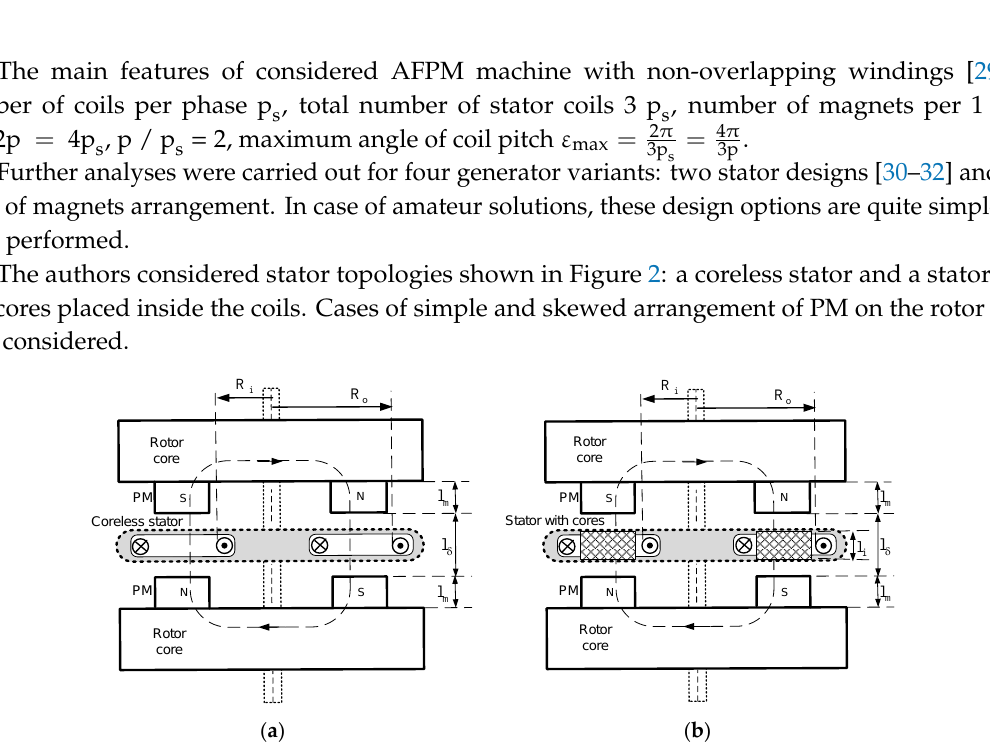
Figure 1. Axial Flux Permanent Magnet (AFPM) generator model with ANSYS Maxwell program: ( a ) stator disc with non-overlapping windings; ( b ) a rotor disc with basic (simple) Permanent Magnet (PM) arrangement; ( c ) assembling.